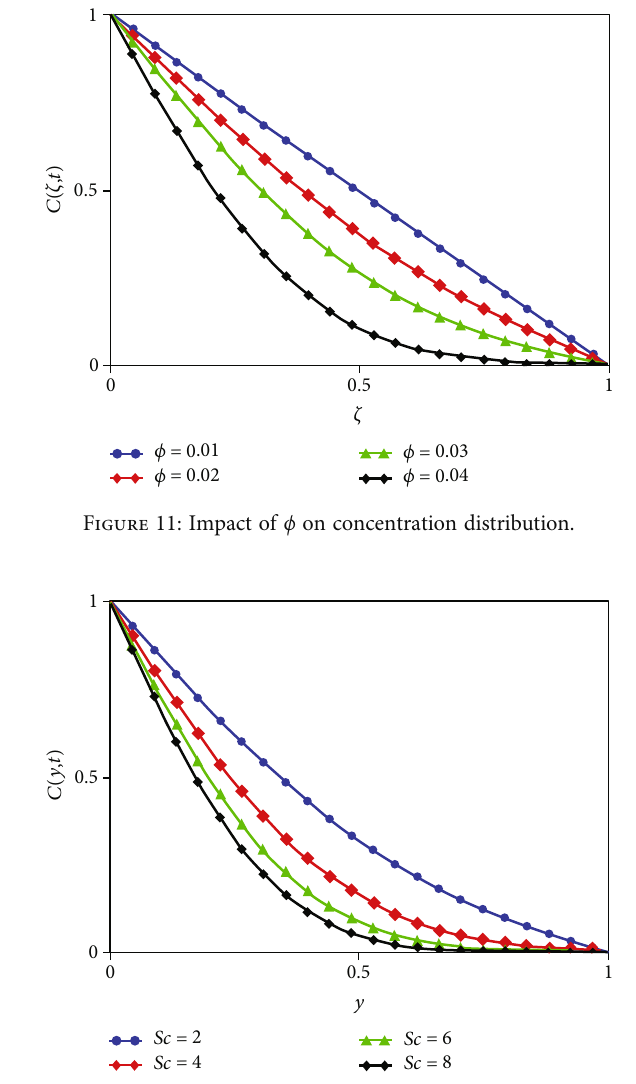
Figure 12: Impact of Sc on concentration distribution. Table 1: Thermophysical properties.